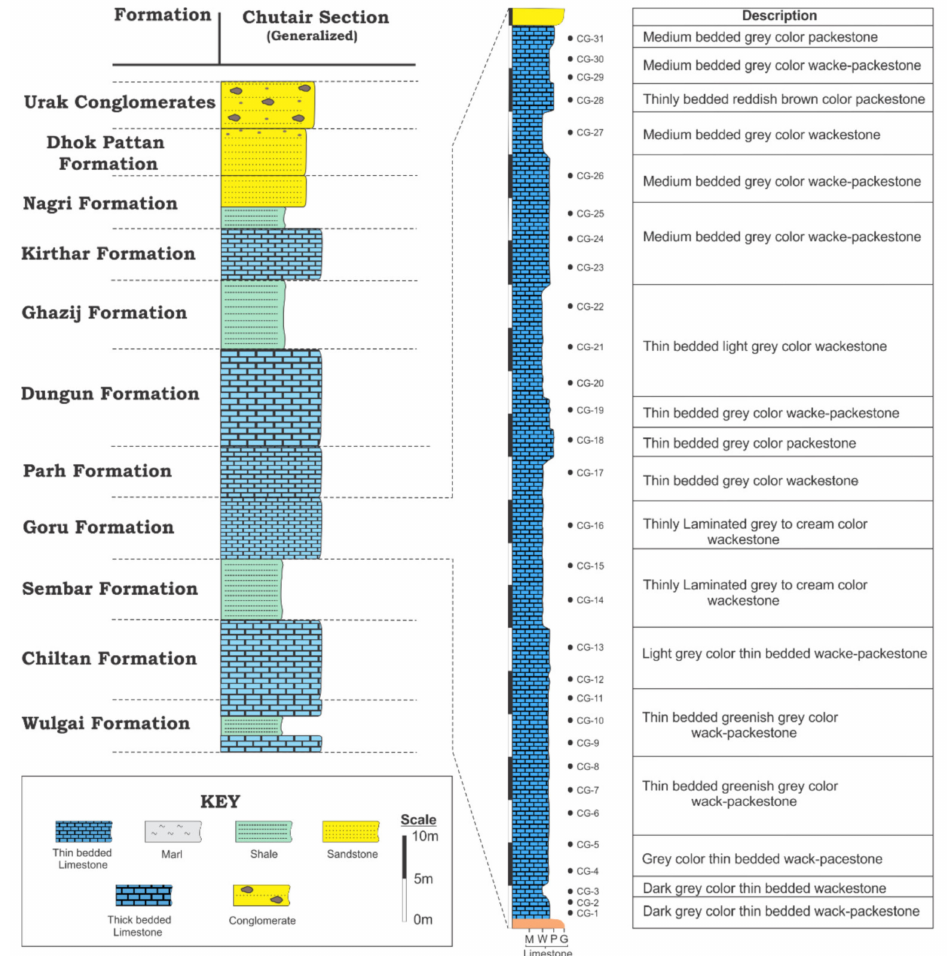
Figure 2. Generalized stratigraphy and lithologic log of Goru Formation at the study area, i.e., Chutair Section (After